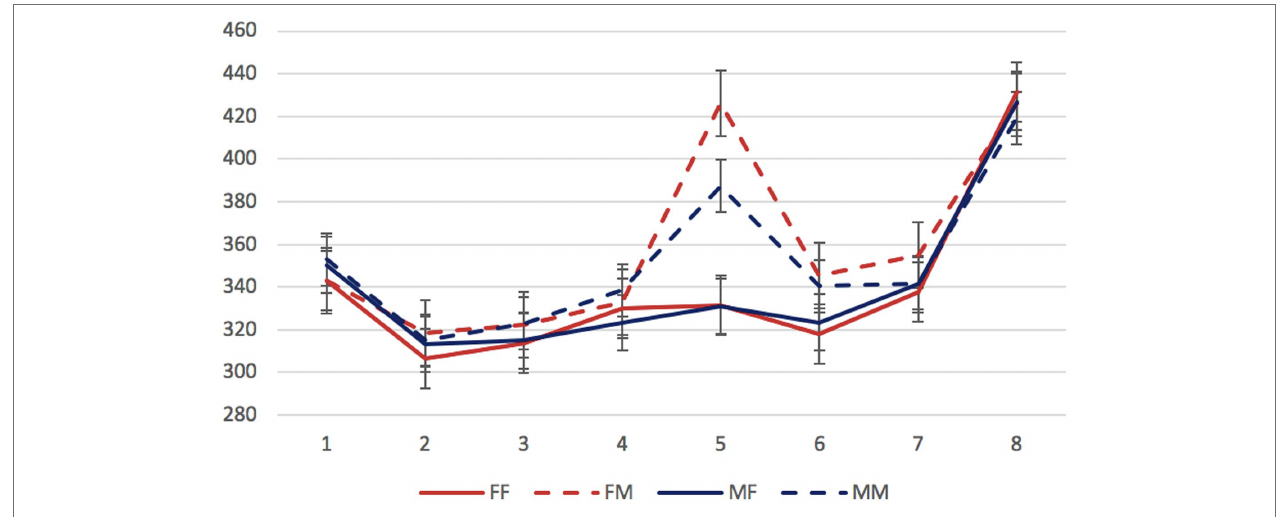
FIGURE 5 | Experiment 2, the non-syncretic head group: mean RTs per region (in ms) in the four experimental conditions. Regions: N 1 (head)—preposition—N 2 (dependent)—copula ( byt’ “ to be”)—adjective/participle—three words modifying the predicate. Error bars represent the standard error of the condition mean.